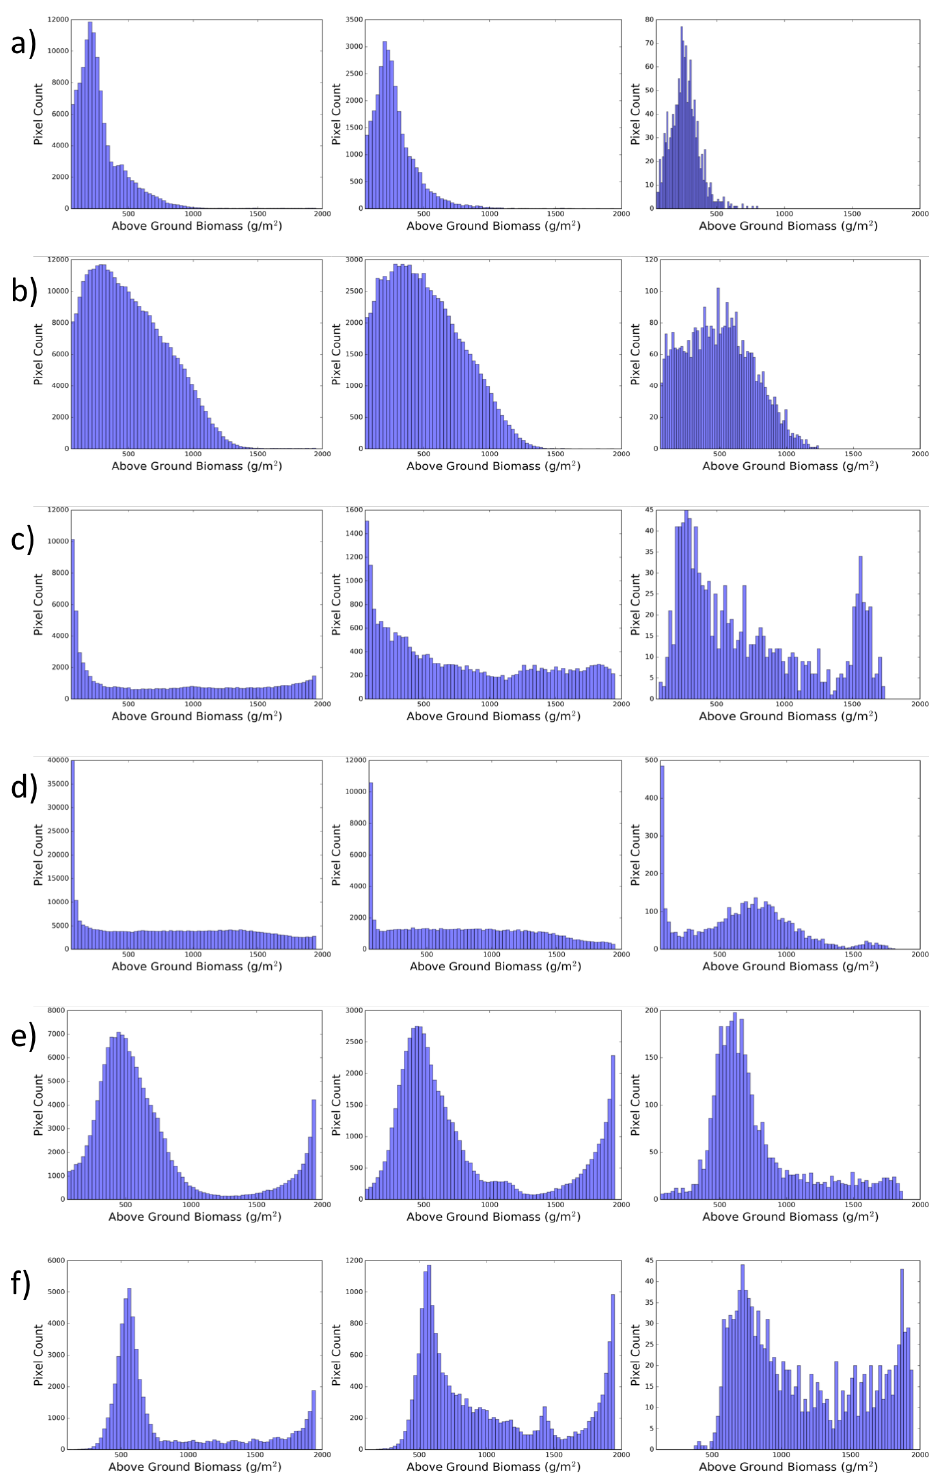
Figure 7. The spatial distribution of the retrieved AGB for ROIs (shown in white) from Figure 6 of the various marsh sites: ( a ) 1850 “short zone at panne edge”; ( b ) 1850 “tall zone at creek bank”; ( c ) 1974 “medium zone at lagoon edge”; ( d ) 1974 “short zone with hummock”; ( e ) 2011 “tall zone at lagoon edge”; and ( f ) 2011 “medium zone with die-off”. The first column shows the histogram at the original spatial resolution, in the second column the spatial resolution has been changed by a factor of four, and in column three by a factor of one